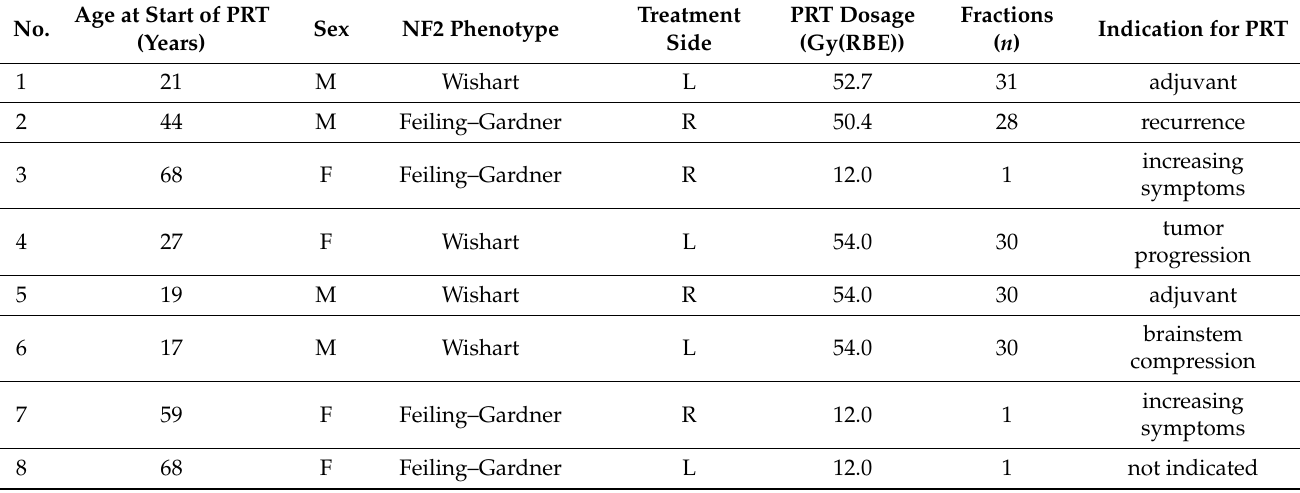
Table 1. Patient demographics and proton radiotherapy treatment plan.